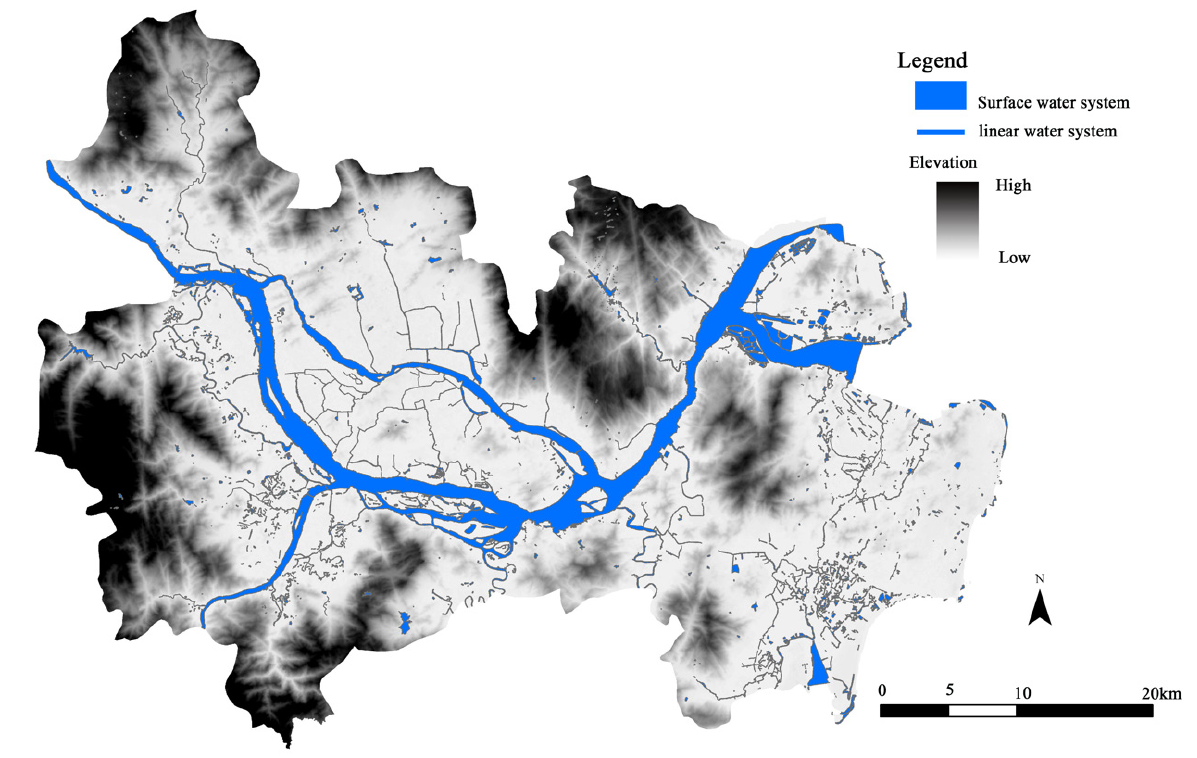
Figure 5. Natural water system in Fuzhou, China.